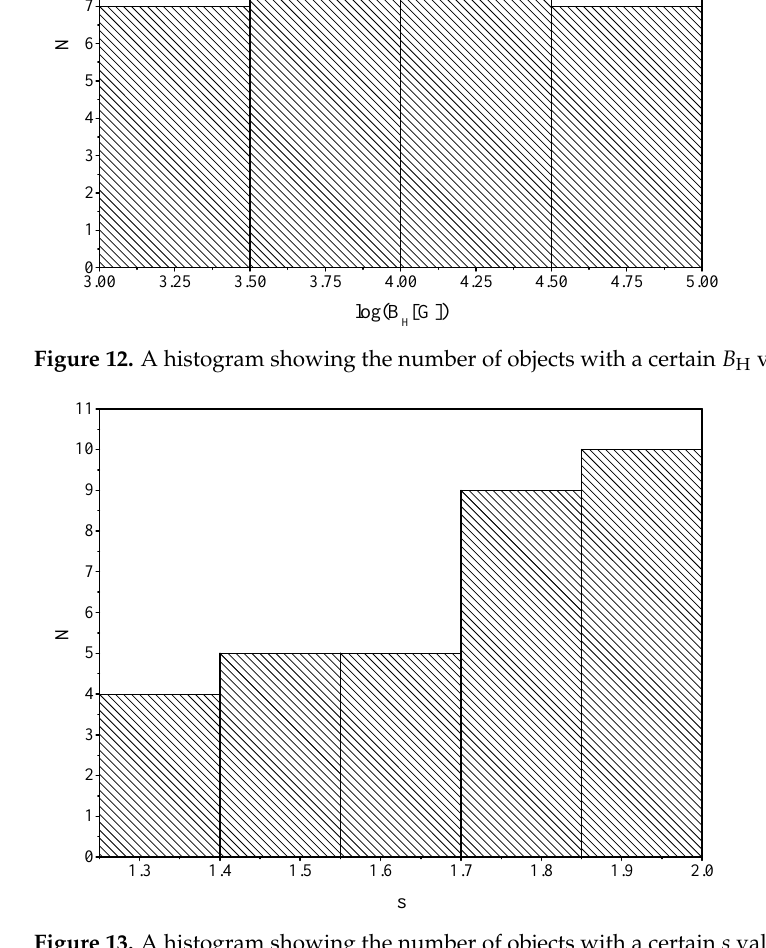
Figure 13. A histogram showing the number of objects with a certain s